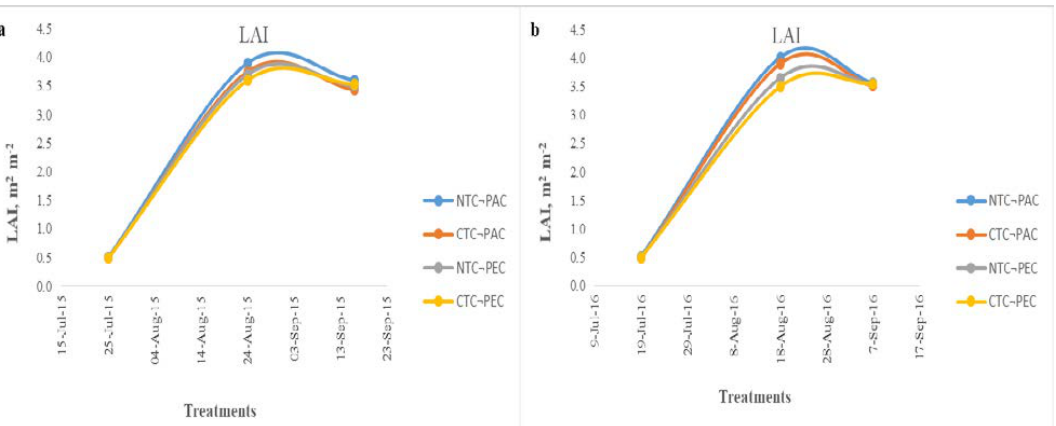
Figure 3. Leaf area index (LAI) of the sunflower cultivation in two growing years of ( a ) 2015–2016 and ( b ) 2016–2017. NTC-PAC: no tillage planting parallel to the contour direction. CTC-PAC: conventional tillage planting parallel to the contour direction. NTC-PEC: no tillage planting perpendicular to the contour direction. CTC-PEC: conventional tillage planting perpendicular the contour direction.